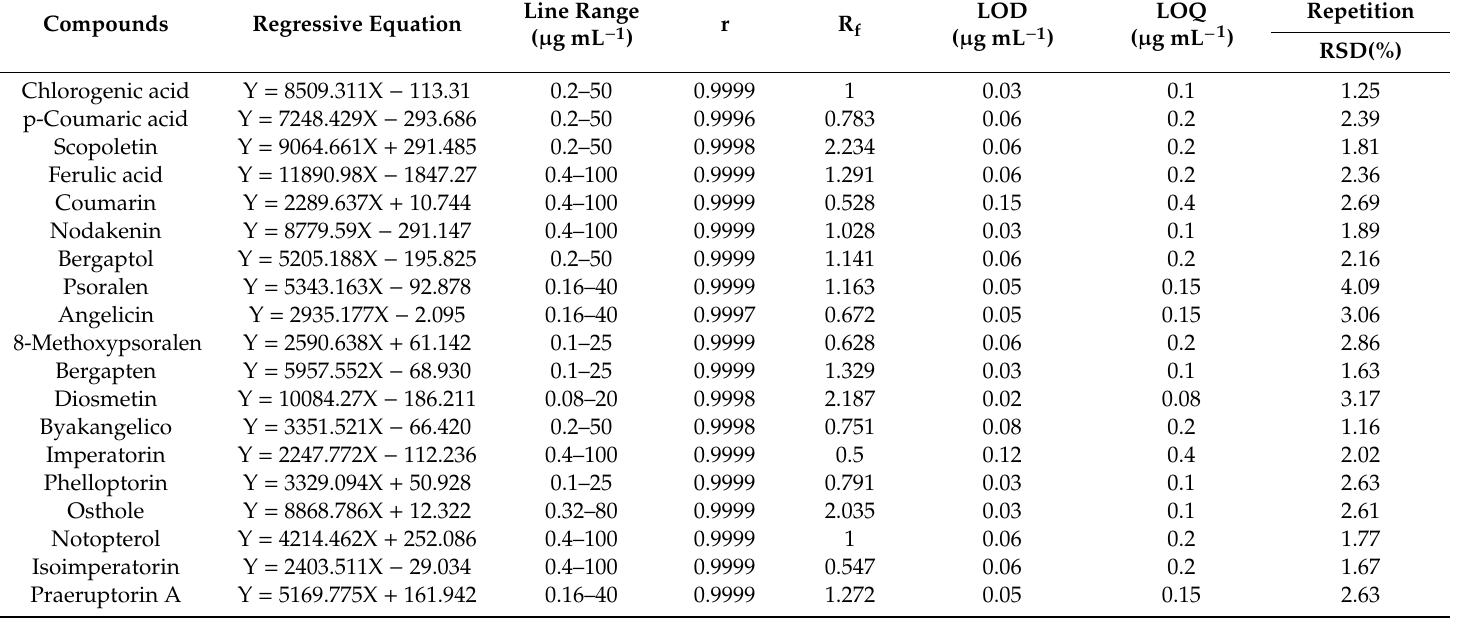
Table 1. Data for the calibration curves, LODs, LOQs, R f and Repeatability using the SSMD method ( n =